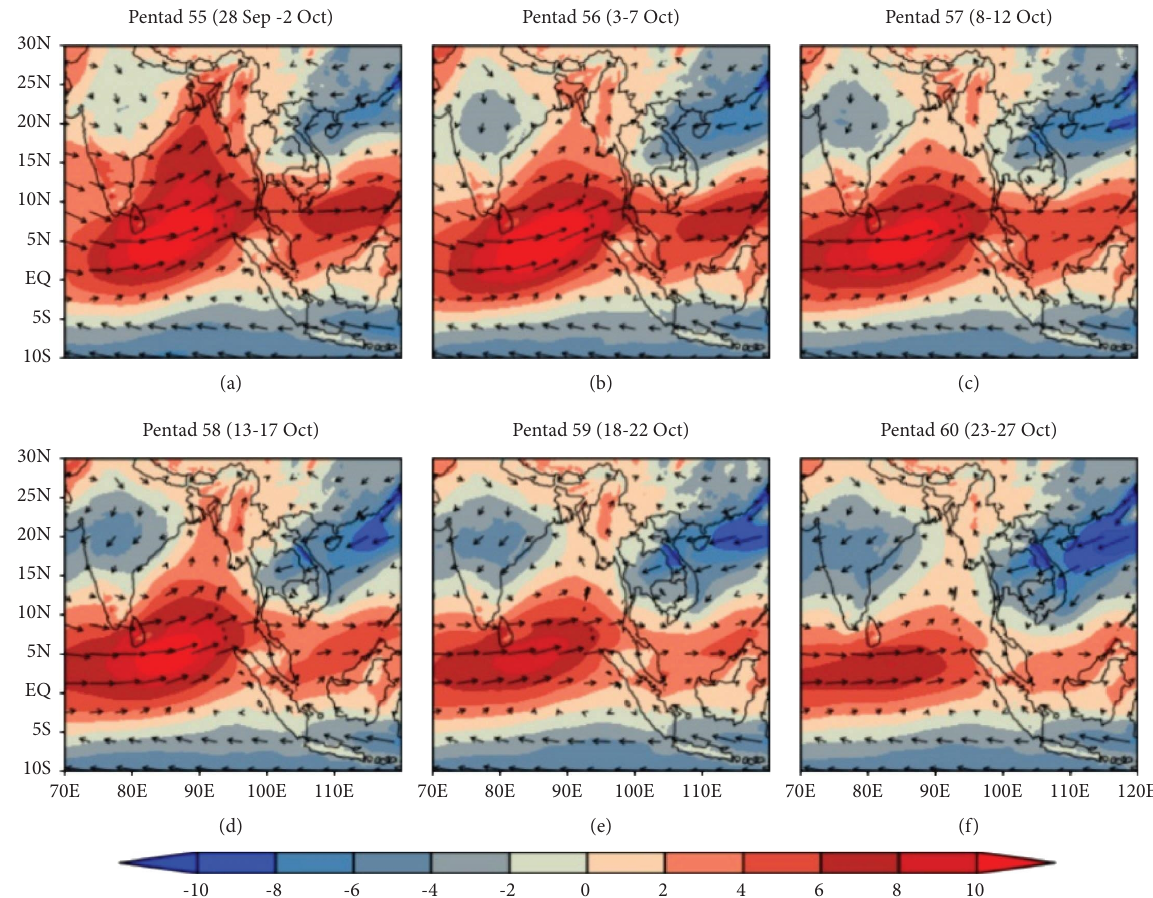
Figure 14: Composite of climatology (1991–2020) wind component strength (ms − 1 , colour) and wind direction (vector arrow) at 850hPa level during the pentads: (a) P -55 (Sep 28–Oct 2), (b) P -56 (Oct 3–7), (c) P -57 (Oct 8–12), (d) P -58 (Oct 13–17), (e) P -59 (Oct 18–22), and (f) P -60 (Oct 23–27) during the monsoon withdrawal